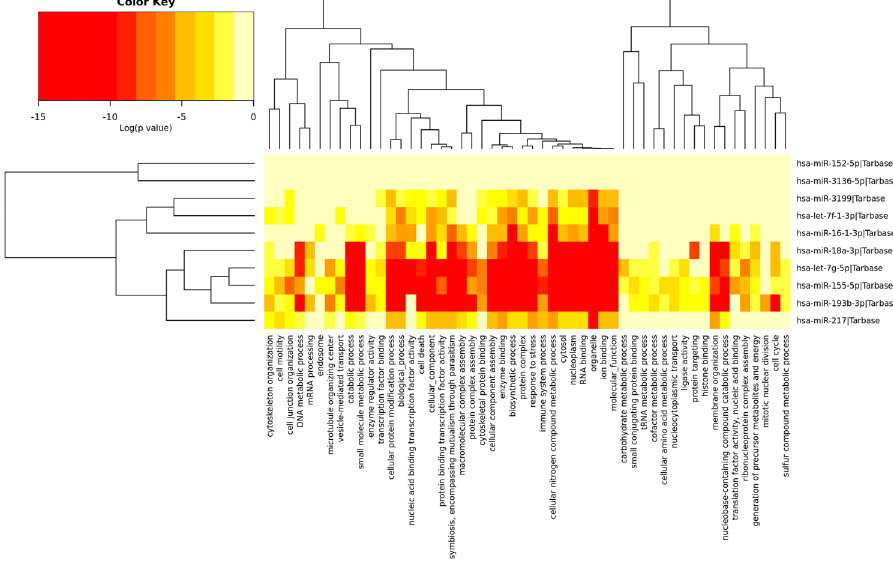
Figure 4. Heat map of the GO term analysis. Top-10 miRNAs involved in cellular component, molecular function and biological pathways in